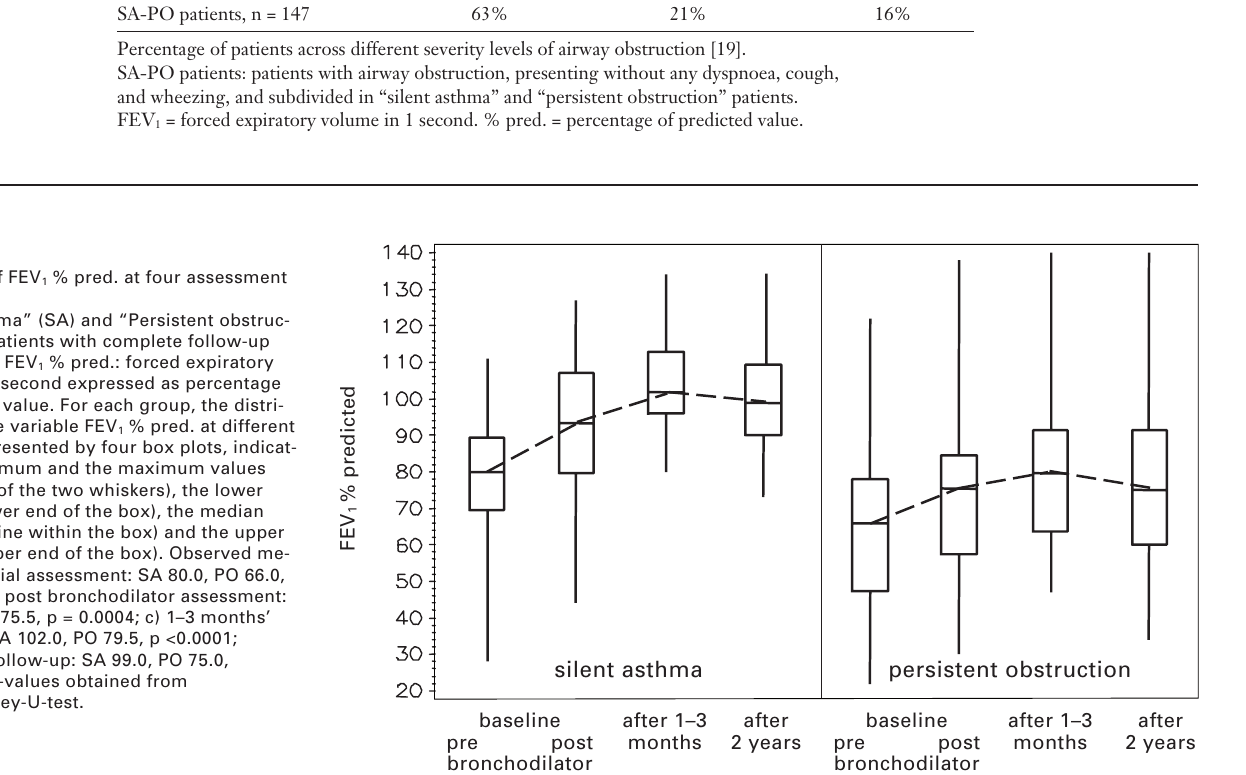
Table 4 Severity of airway obstruction seen at first assessment visit.